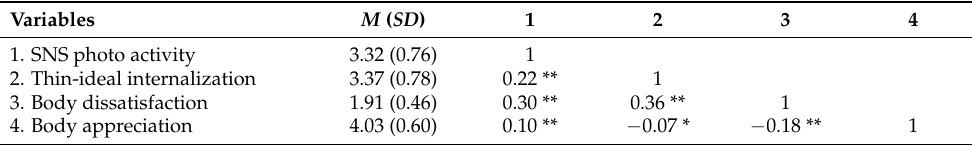
Table 1. Descriptive statistics and correlation matrix between variables.